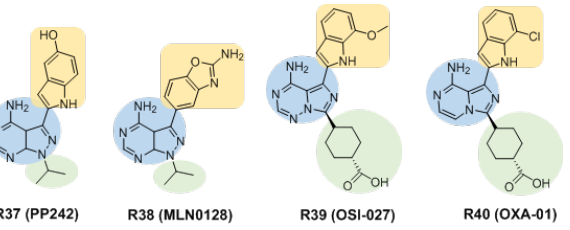
Figure 6. Structures of inhibitors based on pyrazolo [3,4- d ]pyrimidin-4-amine. They are described as scaffold involving three regions: the hinge region (blue), the hydrophobic region (buff) and variable region (green).